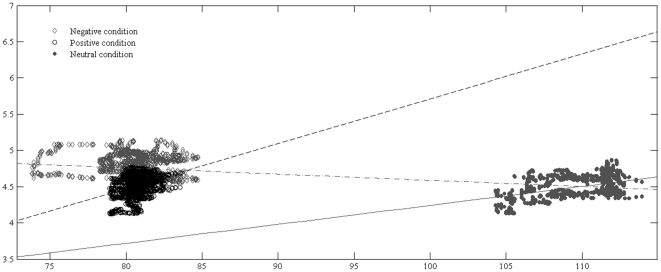
The effect of stimulus luminance on pupil dilation. We explored whether variations in stimulus luminance across video frames have a significant effect on the recorded changes in pupil size. It was predicted that as stimulus luminance increases, an adjustment reaction with decreasing pupil size would be recorded. It was found that the emotional valence of the stimuli explained a big proportion of the variation, partial
η2 = .32, while variations in luminance across the movies had an extremely small effect, partial
η2 = .04. The relation between the effect of luminance on pupil size differed across emotions (F(2, 7500) = 217.77, p<.001). When controlling for other sources of variations between videos [69], the relation between luminance and pupil size is positive (.42), and this could be due to the overall tendency of the pupil to increase with stimulus presentation. Illuminance measured at the level of the eye during the presentation of each video was within a range not expected to yield significant differences in pupil size (15.0±0.5 Lux) [50]. All this information suggests that the observed differences in luminance and illuminance between stimuli could not produce the differences in pupil size related to the emotional valence.